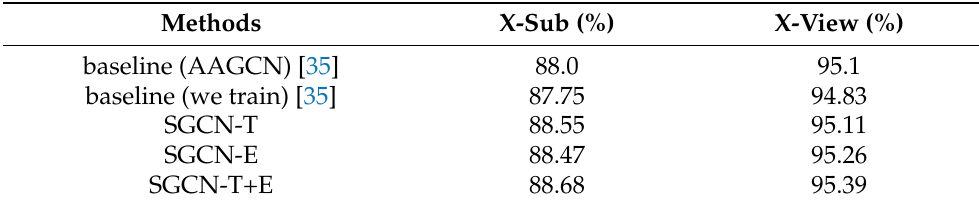
Table 2. Performance comparison on the NTU-RGB+D dataset of the partition strategy with con- nections of 2-hop neighbors, edge joints and the fusion of two modalities. T: 2-hop neighbors, and E: Edge joints.